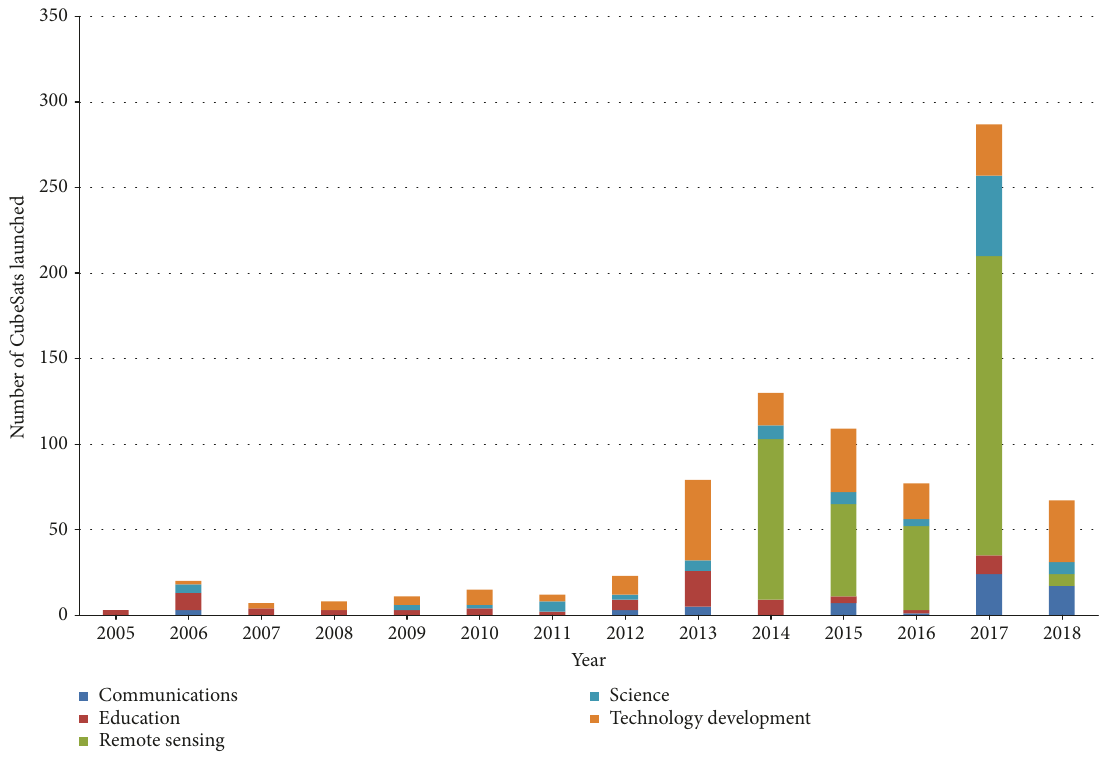
Figure 3: CubeSats launched per year and per application from 2005 to May 31, 2018.